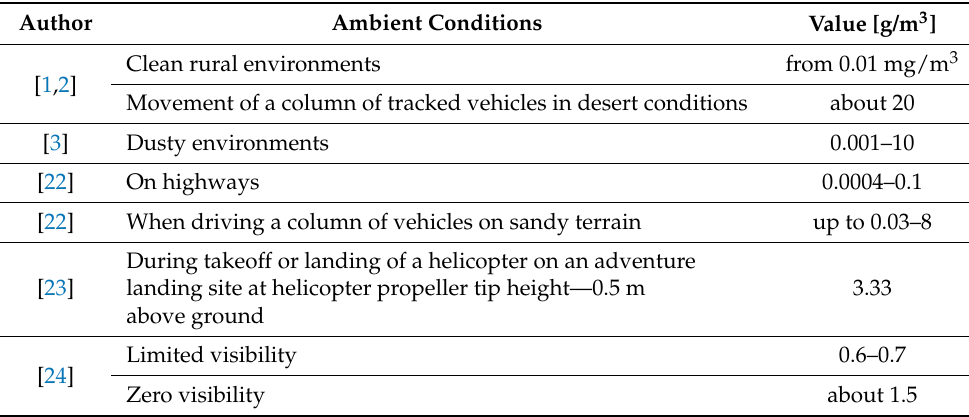
Table 1. Particulate matter concentrations in the air for different vehicle operating